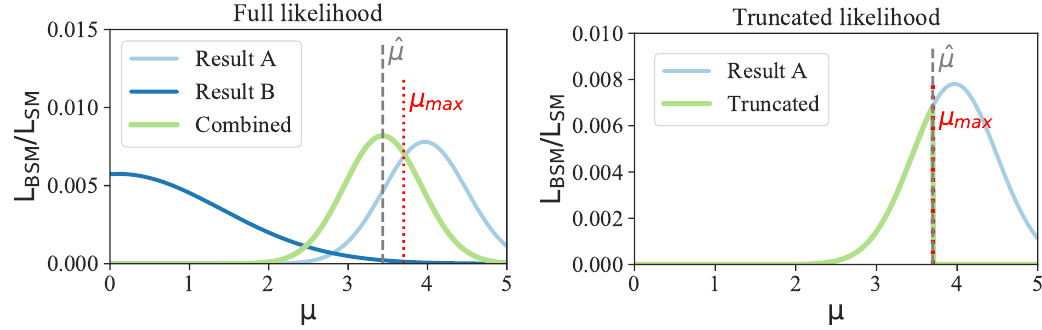
Figure 3 . Left : an illustration of the signal likelihood as a function of the signal strength ( µ ) for two results (A and B) and the corresponding combined likelihood. The value of ˆ µ given by the maximum of the combined likelihood (green curve) is also shown as well as the upper limit on µ ( µ ) given by Result B alone. Right : a similar example, but where it is not possible to max combine both likelihoods, or the likelihood for Result B is not available. In this case the likelihood for Result A is truncated at µ (obtained from Result B). All the curves are normalized to the max corresponding SM likelihood value ( µ = 0